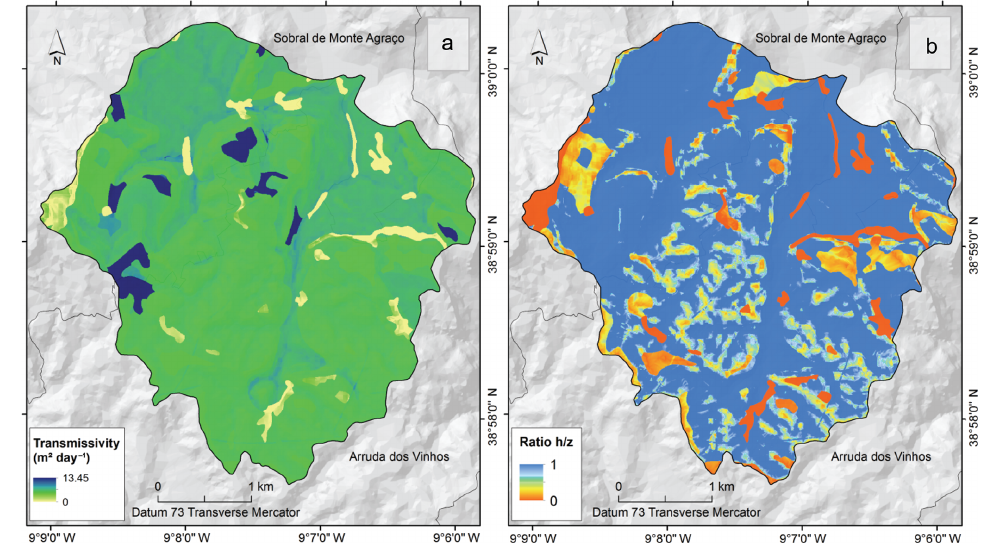
Figure 5. Transmissivity (a) and ratio h/z (b) for the hydraulic model of the study area.